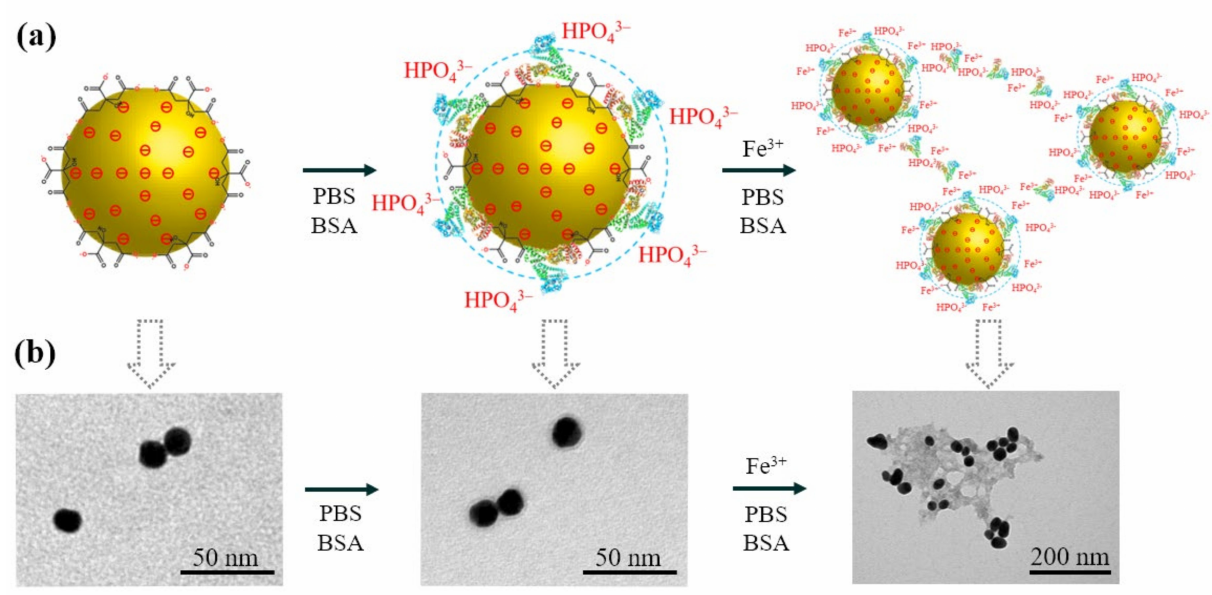
Figure 3. Hypothesis and verification of the synthesis process of Au/Fe 3+ NCs. ( a ) Schematic illustration of the proposed synthesis of Au/Fe 3+ NCs and ( b ) scanning electron microscope images of the